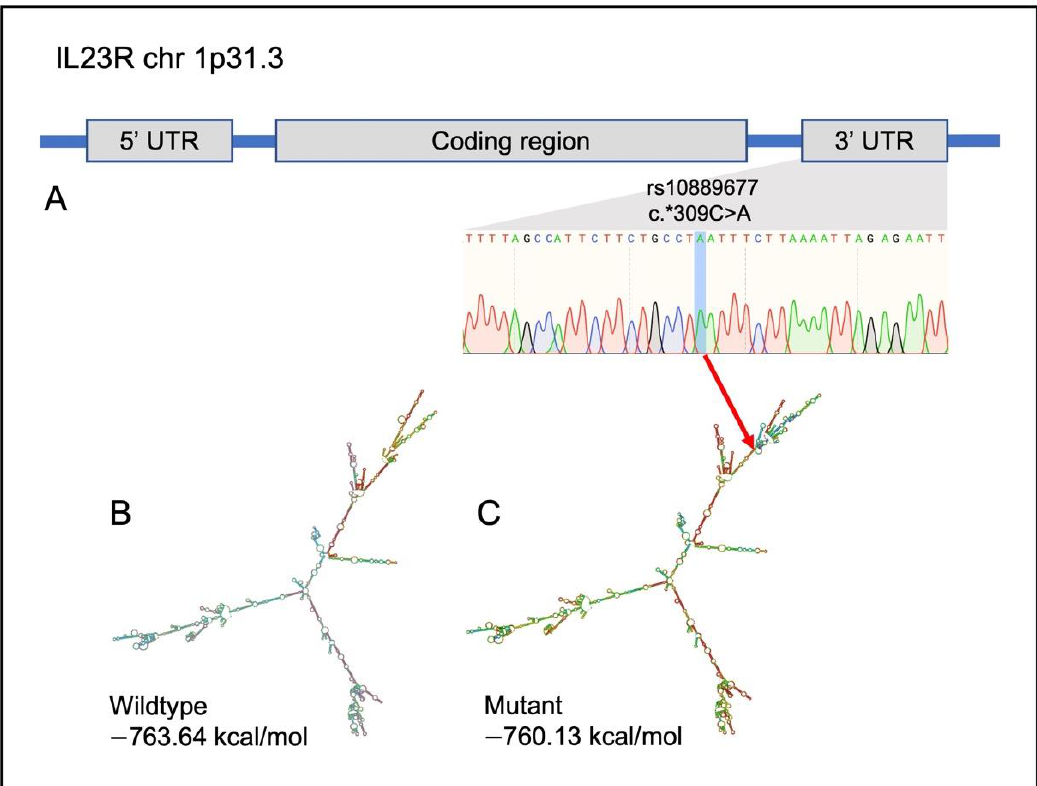
Figure 5. Details on IL23R variant rs10889677 and the in silico prediction of the mRNA secondary structure by RNAfold. ( A ) Location of the variant in the IL23R . ( B ) Wildtype ( C ) Mutant. Red arrow showing the location of nucleotide change [24].